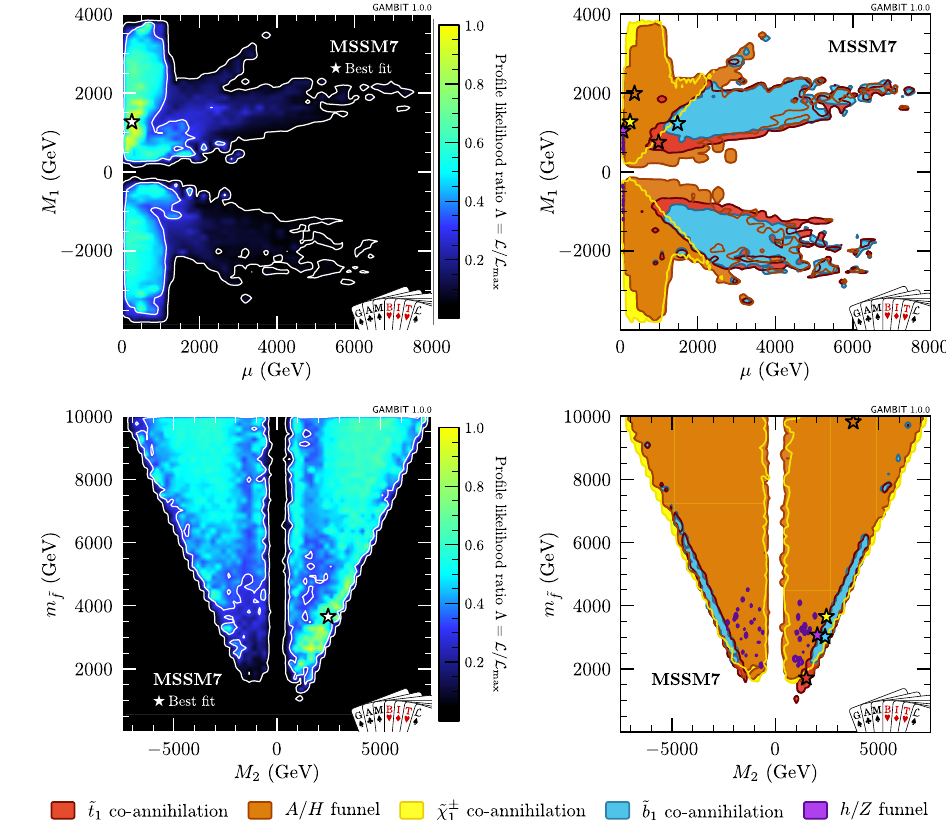
Fig. 3 Left: joint profile likelihoods in the μ – M 1 (top) and M 2 – m ˜ planes (bottom). f Stars indicate the point of highest likelihood in each plain, and white contours correspond to the 1 σ and 2 σ CL regions with respect to the best-fit point. Right: coloured regions indicating in which parts of the 2 σ best-fit region different co-annihilation and funnel mechanisms contribute to keeping the relic density low. The best-fit point in each region is indicated by a star with the corresponding